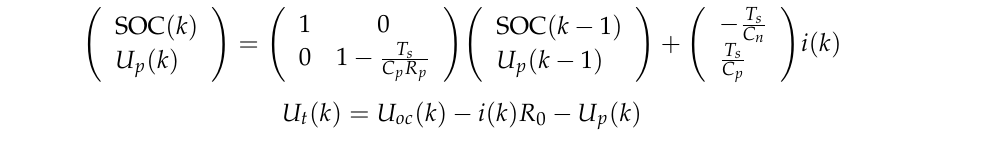
Table 1. Major steps of state of charge (SOC) estimation based on the unscented Kalman filter (UKF).